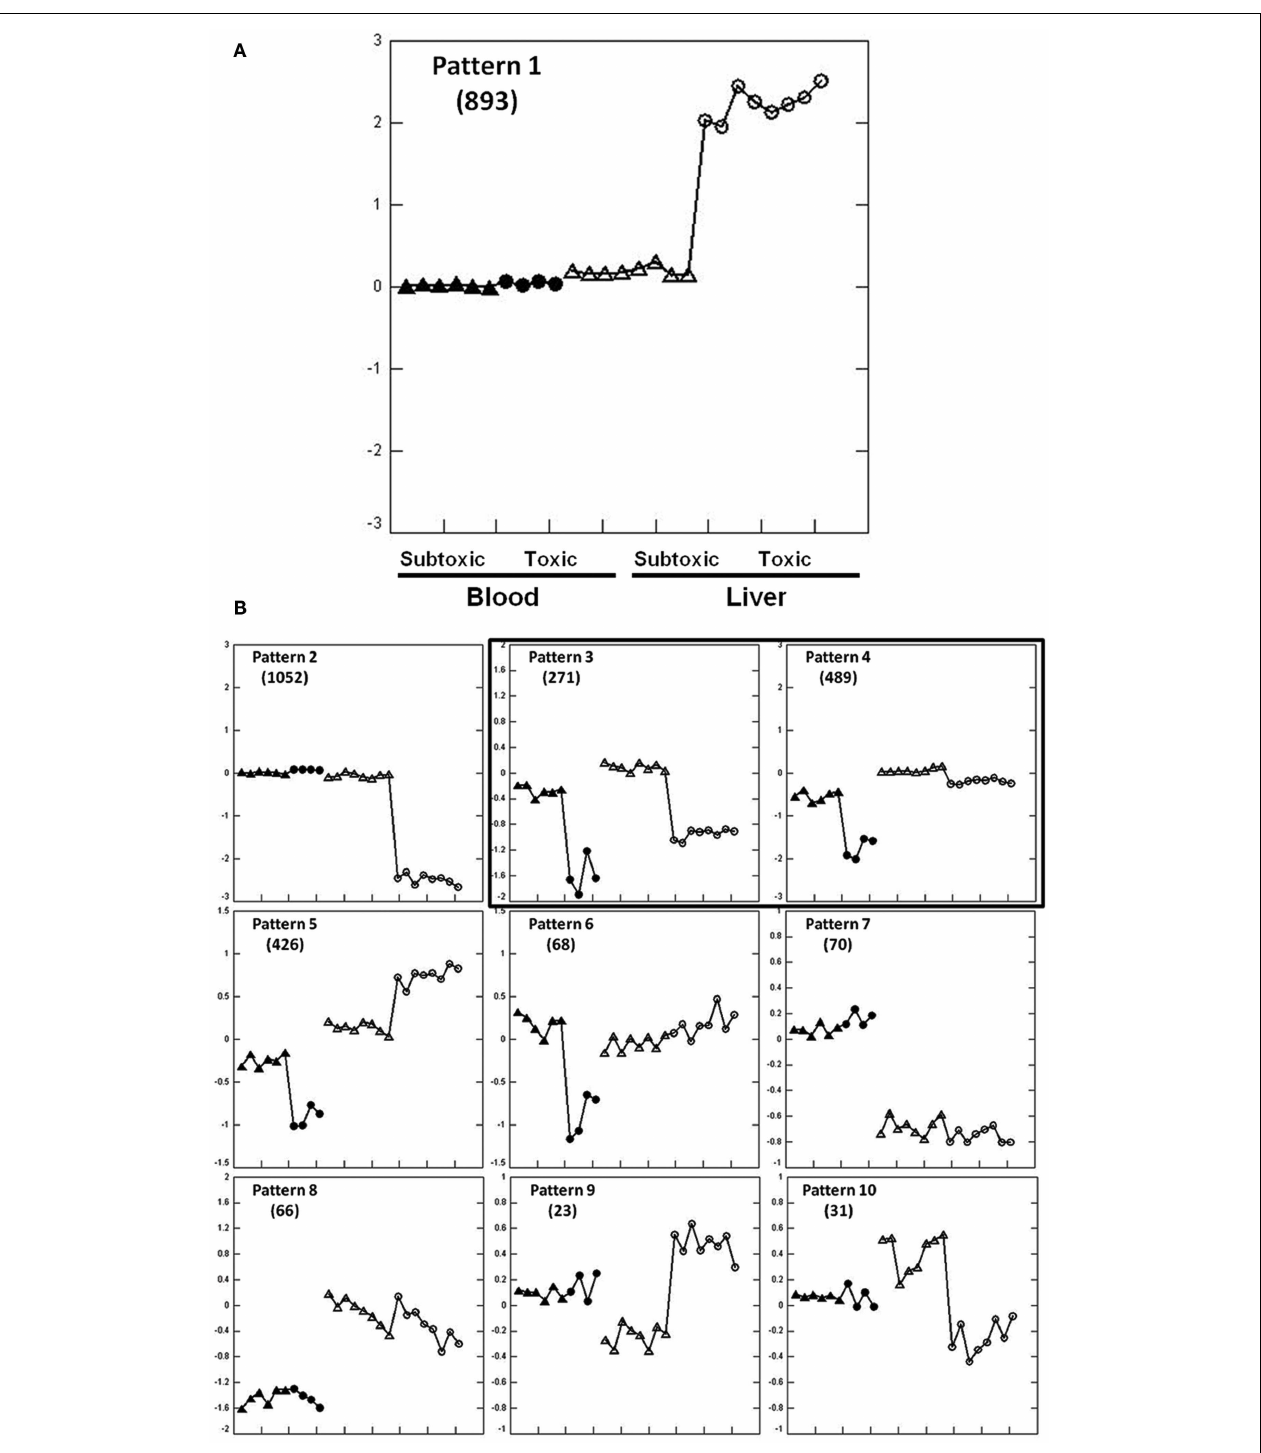
and below zero means down-regulation.Two arrays were hybridized with Cy3 and Cy5 dye swap from one animal, so two dots represent one rat.Within a single pattern from the left to the right: blood (solid dots) and liver (empty dots); within the same tissue from left to right, subtoxic dose (triangle), and toxic doses (circle). Other gene expression patterns are shown in (B) . Gene numbers for each pattern are shown in parentheses. Only pattern 3 and 4 contain genes that were similarly regulated in liver and